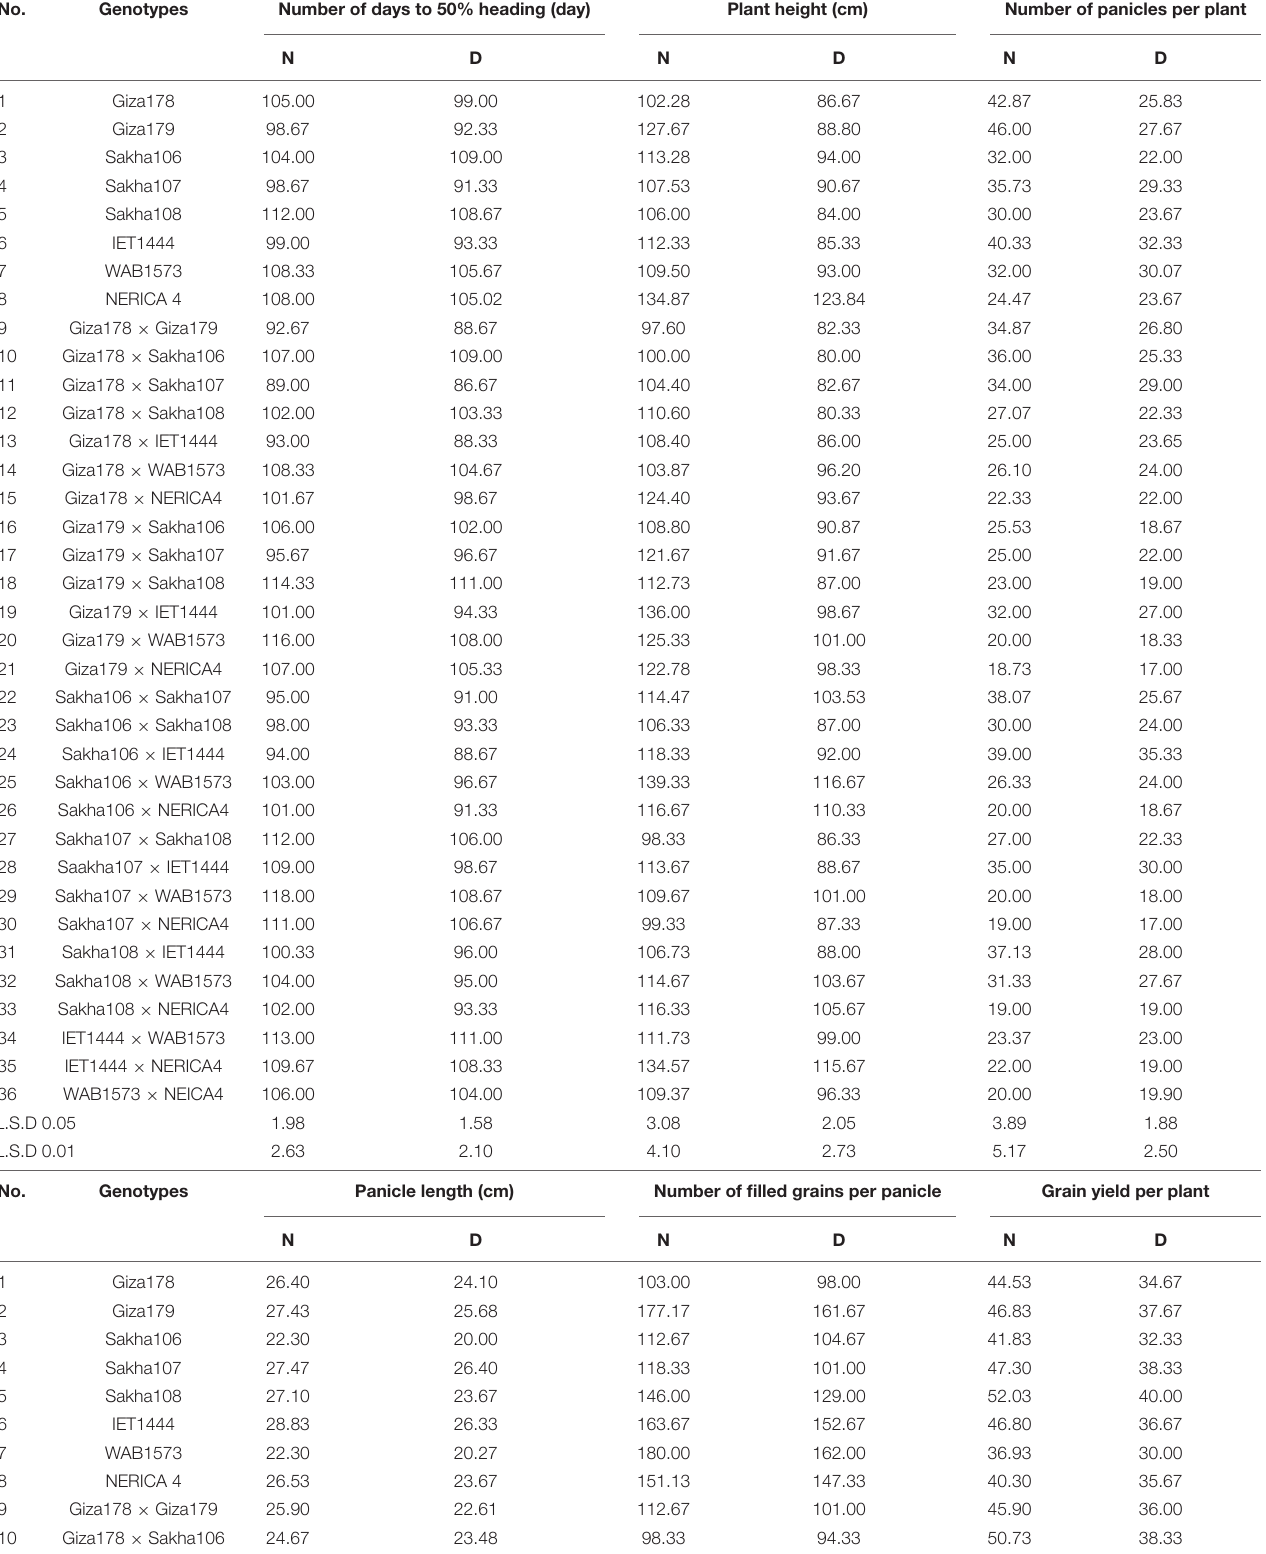
TABLE 4 | Mean performance of parents and their F 1 generation in a half-diallel cross for yield and some related traits under normal and water stress conditions. No. Genotypes Number of days to 50% heading (day) Plant height